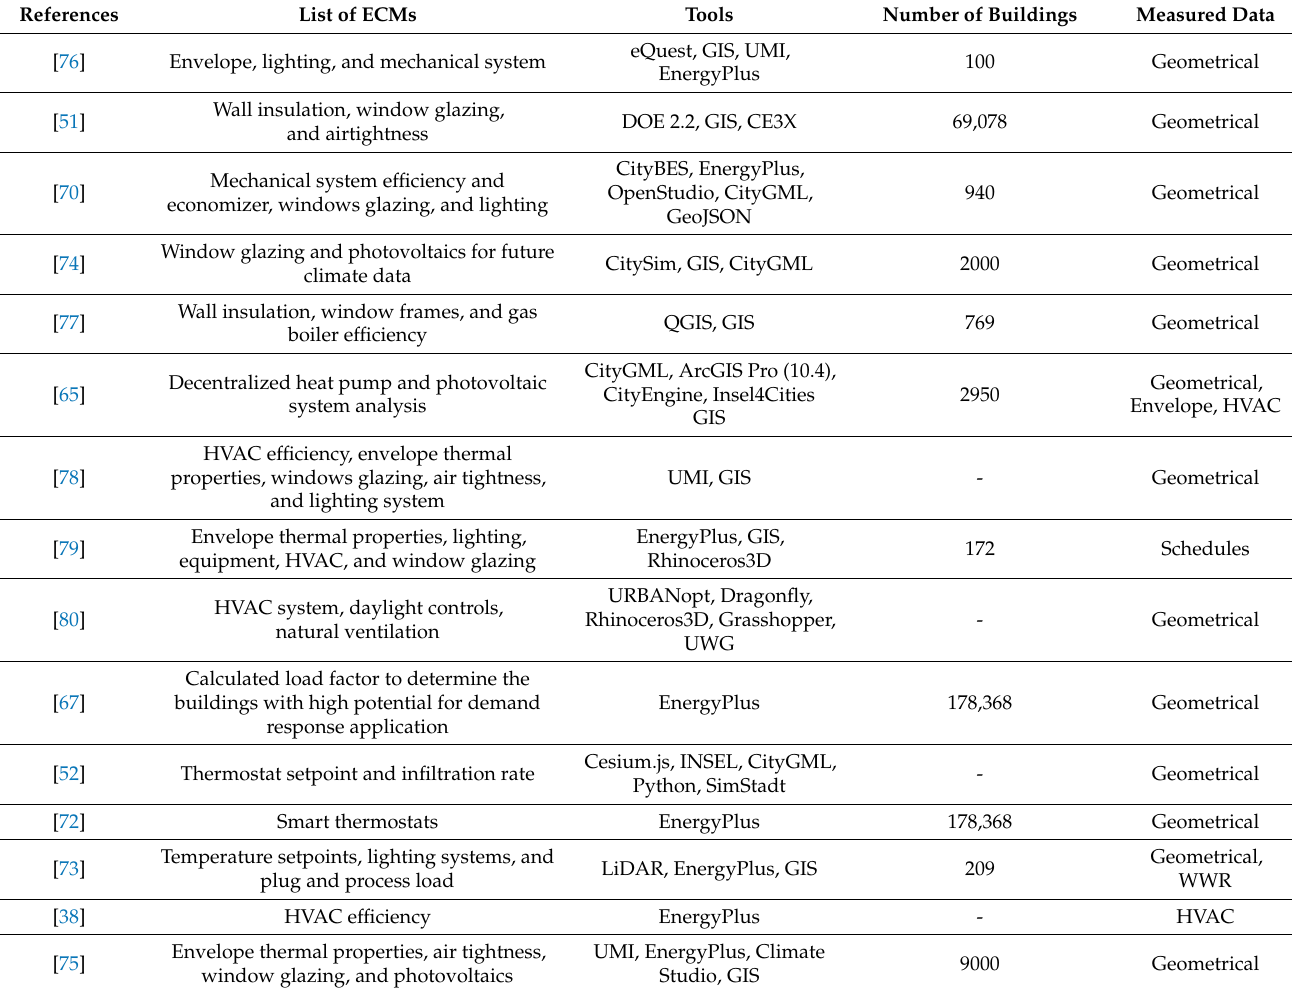
Table 2. Urban building energy modeling studies focused on energy conservation measure